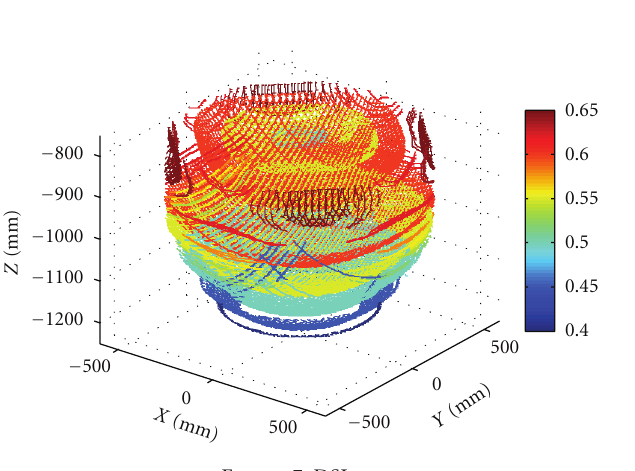
Figure 7: DSI μ Z .